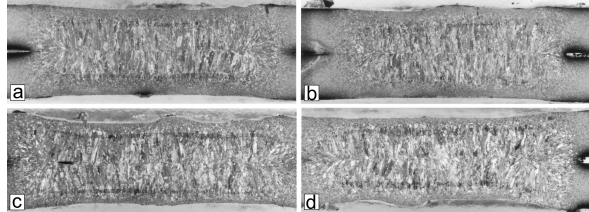
Figure 11: Macrostructures of the welds of H340 LAD steel: a) sam- ple E (I=6.0kA, b) sample F (I=6.6kA, c) samples G (I=7.0kA) and d) sample H (I=7.6kA).